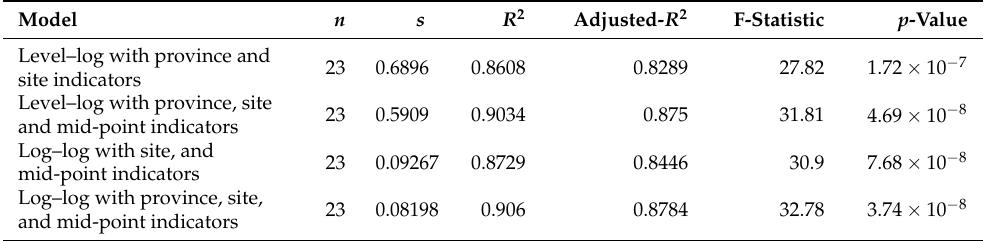
Table 7. Stepwise regression results for modeling nuclear power plants.